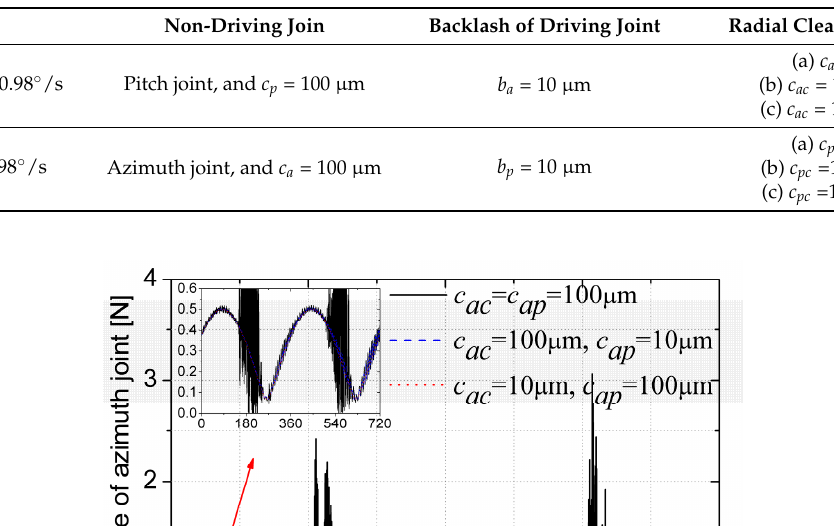
Table 3. Simulation parameters of radial clearance.